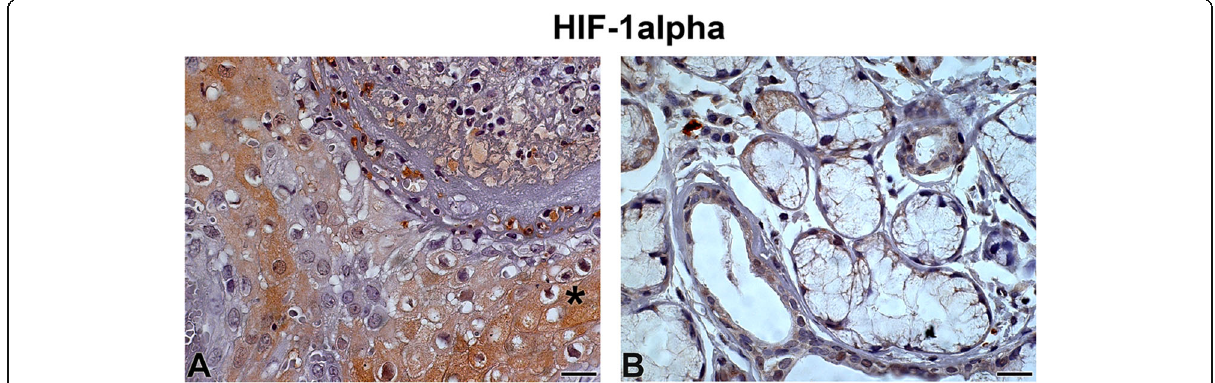
Fig. 1 HIF-1 α Legend: Immunostaining of hypoxia-inducible factor 1 alpha in adenoid cystic carcinoma ( a ) and normal-looking salivary gland ( b ). Immunoperoxidase. Scale bar: 20 μ